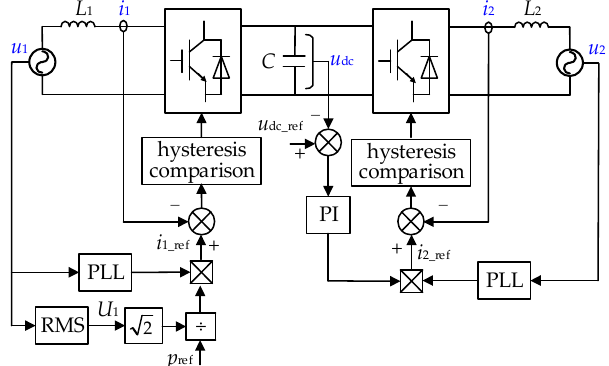
Figure 4. Control block diagram of the energy transfer converter (ETC).